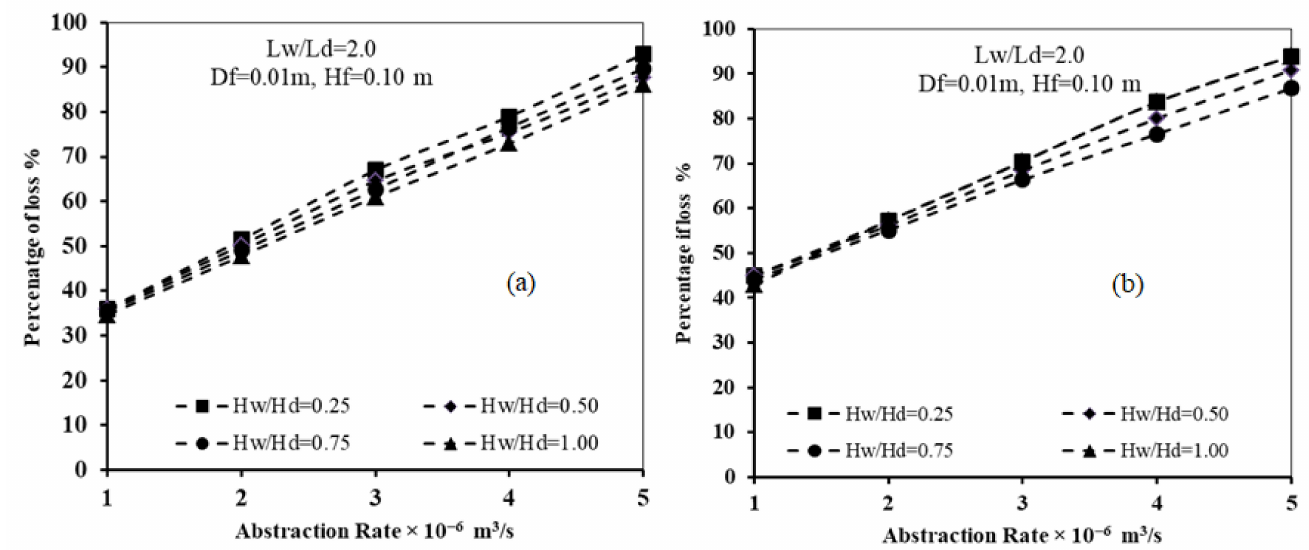
Figure 15. Relation between abstraction rate and loss of subsurface dam effectiveness D F = 0.01 m, H f = 0.1 m for different values of saltwater density: ( a ) density = 1025 kg/m 3 ( b ) density = 1030 kg/m 3